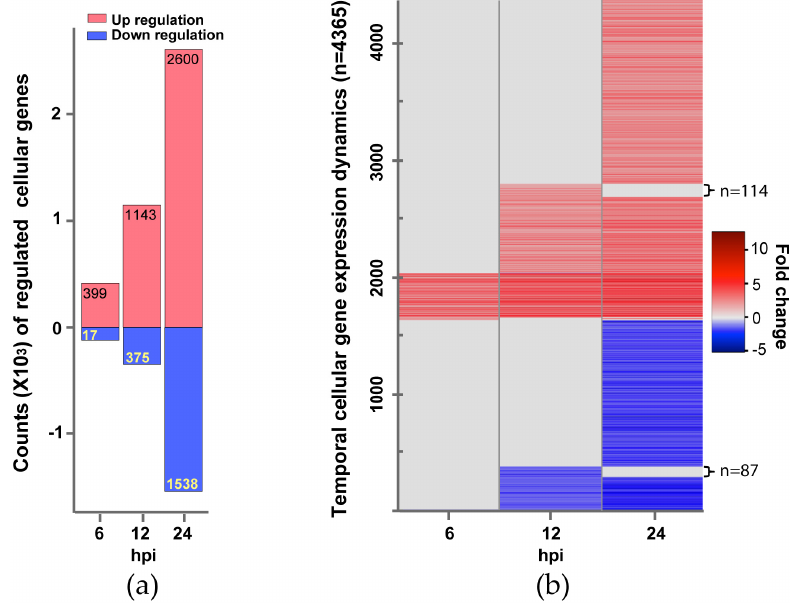
Figure 1. Changes of Influenza B virus (IBV)-regulated cellular genes over time. ( a ) Counts of genes up-regulated (expression level increase is ≥ 2 fold) or down-regulated (expression level reduction is ≥ 1 ) are shown in red or light blue bars, respectively. Di ff erential expression statistical analysis was 2 conducted using DESeq. ( b ) Gene expression Dynamics. A total of 4365 genes showing changed